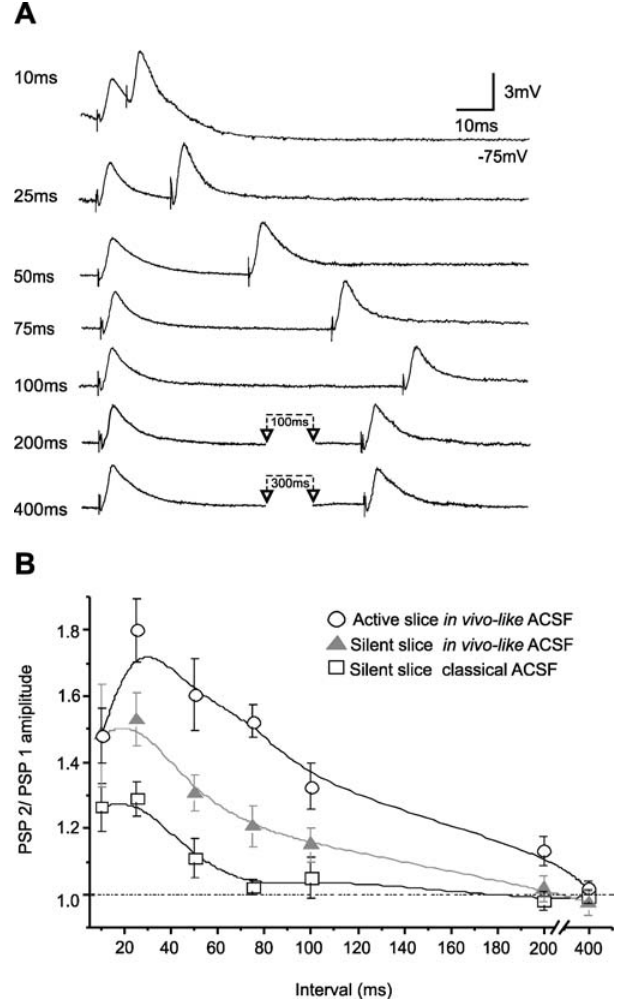
Figure 2. Paired pulse facilitation in active versussilent slices. A. Raw traces of a paired pulse protocol in a layer 2/3 neuron. Pairs of PSPs were evoked with different intervals (10–400 ms) by electrical stimulation of layer 4 in a silent slice in ‘in vivo-like’ ACSF. B. Relative amplitude of the second PSP with respect to the first one (PSP2/PSP1) represented for different intervals (10–400 ms) in three different functional states of the slices: active, oscillatory slice in ‘in vivo-like’ ACSF (n=10; # ), silent slice in ‘in vivo-like’ ACSF (n=11; m ) and silent slice in ‘classical’ ACSF (n=12; % ). The error bar represents 6 s.e.m.